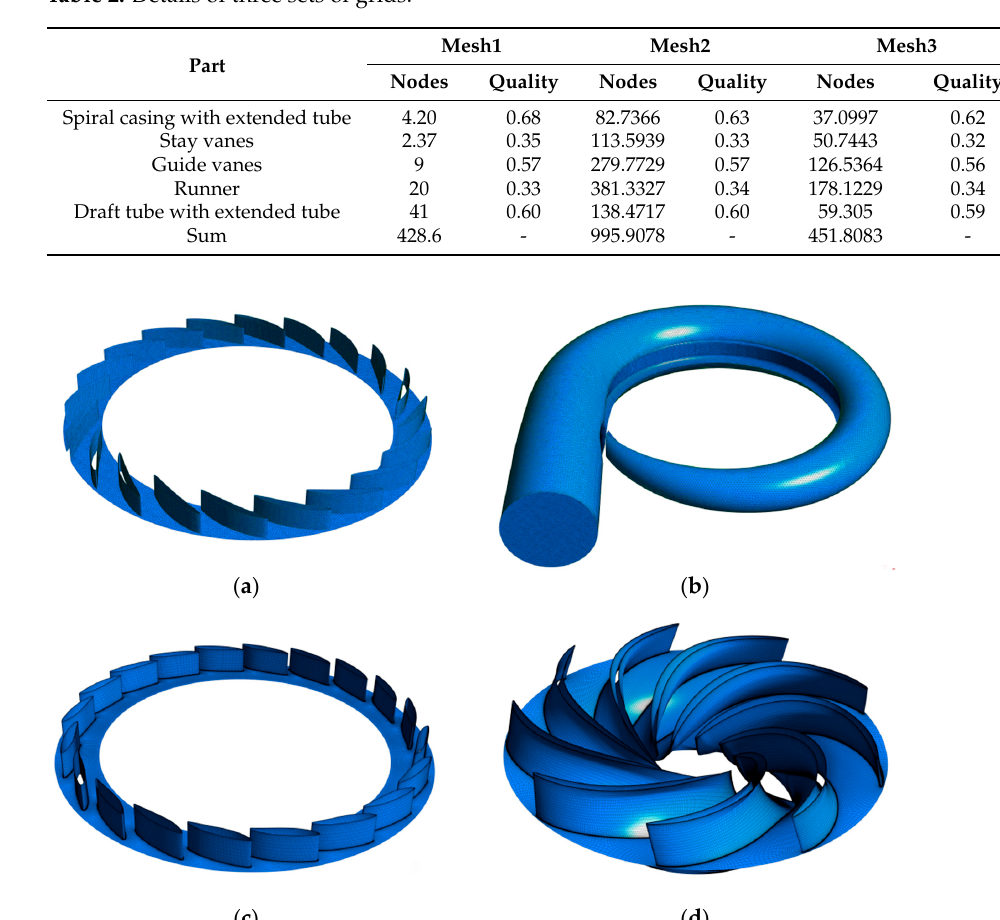
Figure 3. A schematic of grid details: ( a ) stay vanes; ( b ) spiral casing; ( c ) guide vanes; and ( d ) run-